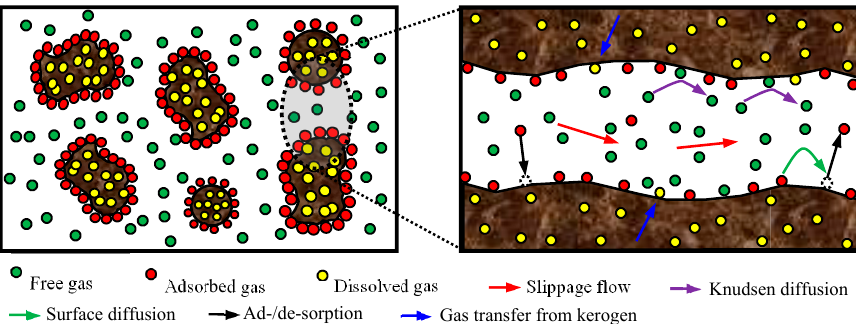
Figure 17. The storage form and flow mechanism of shale gas in organic nanopores [38,41].